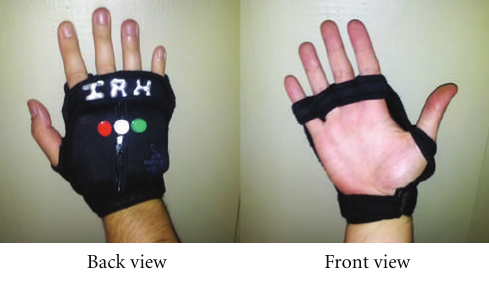
Figure 3: PERCEPT